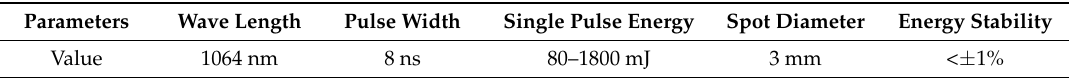
Table 2. Parameters of the utilized laser.